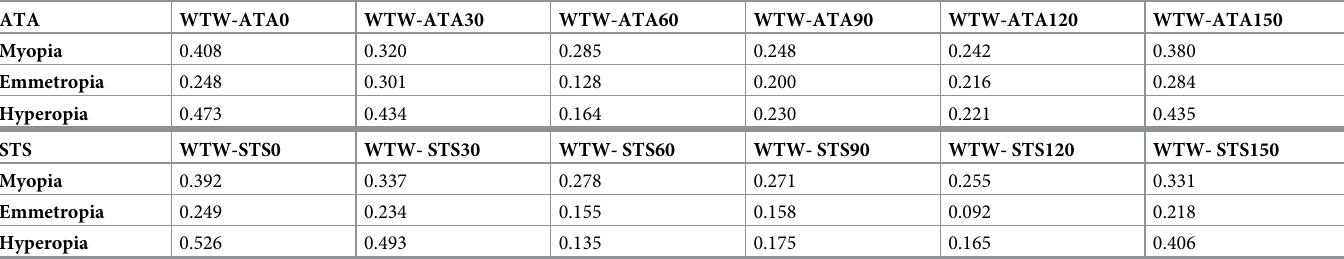
Fig 2. Angle to angle (blue lines) and spur to spur (red line) distances measured at the different meridians. Horizontal white to white was added and shown as orange lines for comparison. Radial axis starts at 5 mm. Diff. means the difference in value between the ATA and the STS. https://doi.org/10.1371/journal.pone.0277703.g002 AL and ACD showed a significant positive correlation with ATA in all groups. In the corneal curvature, there was no significant correlation in the myopia group, and there was a significant negative correlation in some meridians (ATA-60 and ATA-90 in Sim K steep, and ATA-0 and ATA-90 in Sim K flat) in the emetropic group. In the hyperopia group, there was a significant negative correlation in all meridians. Table 3. Pearson correlation coefficient for horizontal white to white (WTW) versus angle to angle (ATA) and spur to spur (STS) measured at different meridians in each refractive group. All results had a statistical significance (p <